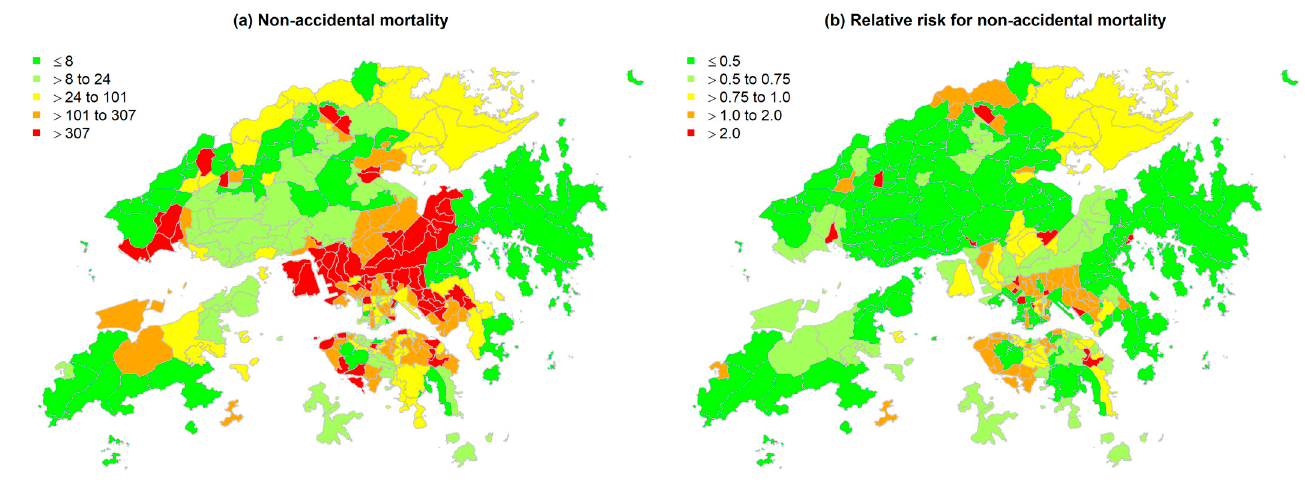
Figure 2. Environmental exposures in Hong Kong in 2016. Note: ( a ) minimum temperature (°C); ( b ) green space density (%); ( c ) NO 2 (µg/m 3 ).